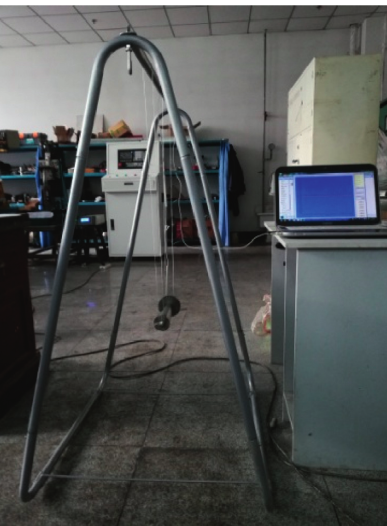
Figure 4: The experimental platform.